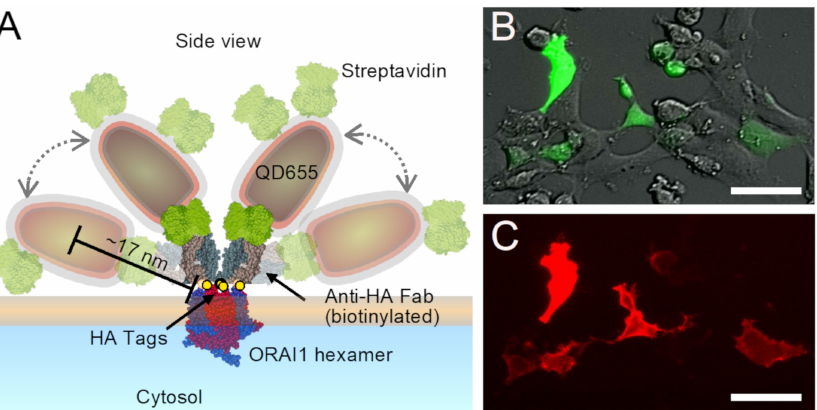
Figure 1. Labeling of ORAI1 proteins in the plasma membrane of HEK cells with quantum dots (QDs). ( A ) Schematic representation of QD-labeling of the ORAI1 Ca 2+ channel in the plasma membrane. Labels consisted of a biotinylated anti hemagglutinin (HA) antigen-binding fragment (Fab) that bound to the HA-tags (yellow spheres) at the extracellular region of each subunit of the ORAI1-HA channel, shown in hexameric conformation (blue and red). The bound Fab was labeled using streptavidin (green) conjugated fluorescent QDs with an electron-dense core (dark gray), and an electron transparent polymer coating shell (red/grey). Several possible spatial positions are shown of two exemplary bound QDs, the positions showing half-transparent labels represent a maximally extended configuration. The representation of all involved molecules reveals a maximum distance between the center of a bound QD and the ORAI1 hexamer of 17 nm. All protein structures were derived from the Protein Data Base, sizes of QDs were measured elsewhere [9], and all structures are drawn to scale. ( B ) Overlay of direct interference contrast light microscopy and fluorescence microscopy of green fluorescent protein (GFP) intracellularly co-expressed with the same ratio as ORAI1. ( C ) Fluorescence images of QD-labeled ORAI1 at rest showing overlap with the cells expressing ORAI1 visible from GFP in ( B ). Scale bars = 50 µ